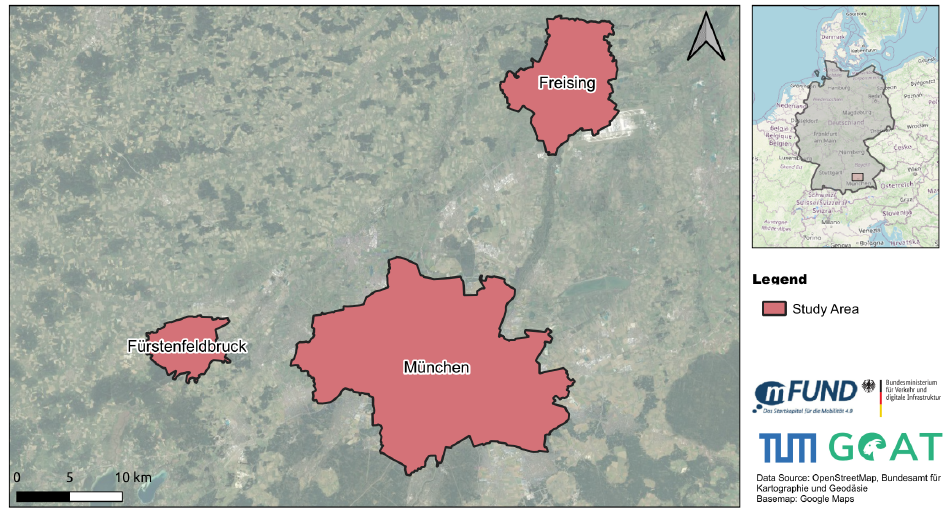
Figure 1. Studied